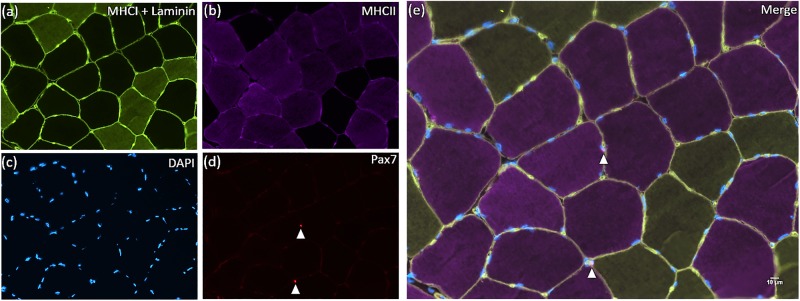
Representative image of the immunofluorescent stain.(a) MHCI/Laminin; (b) MHCII; (c) DAPI; (d) Pax7; and (e) MHCI/Laminin/MHCII/Pax7 (Merge). Arrows denotes SC (upper arrow: SC cell associated with a type II fibre; lower arrow: SC cell associated with a type I fibre).